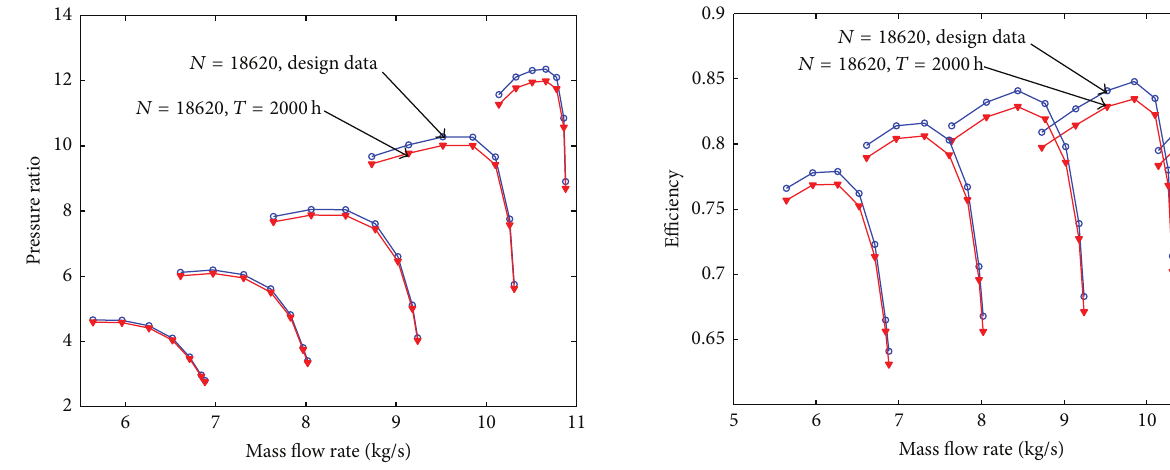
Figure 15: The efficiency curve with 400 hours due to fouling with different relative fouling severity coefficient.